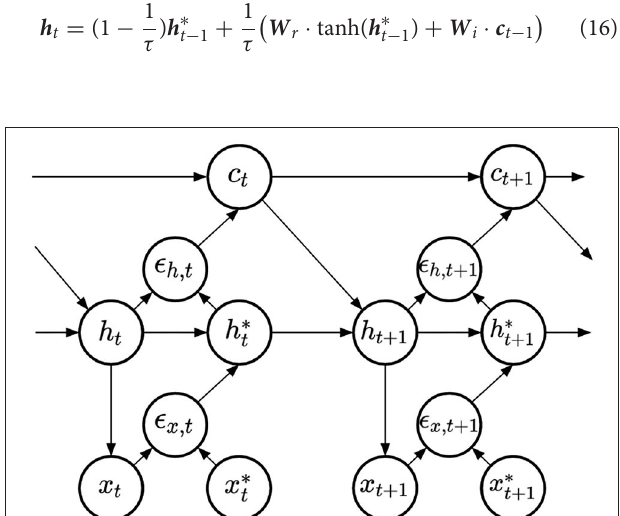
FIGURE 4 | PC-RNN-HC